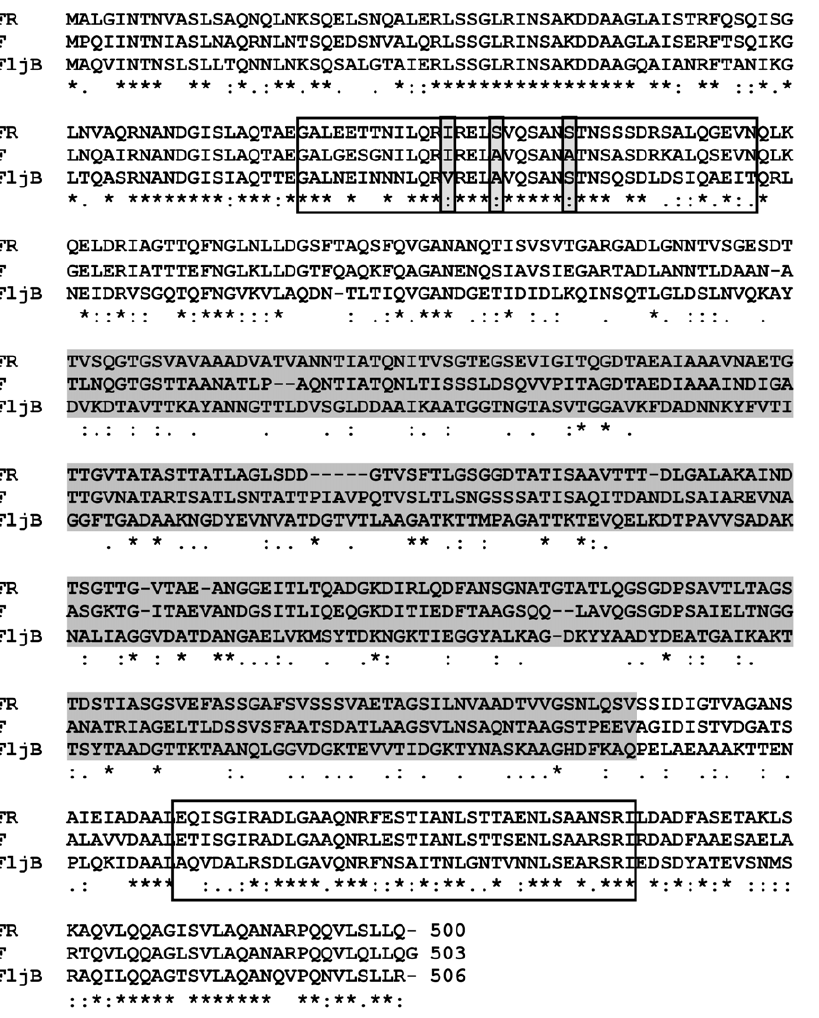
Figure 1. Comparison of the flagellin amino acid sequences of MA (FR and F) and STF (FljB). Boxed areas indicate putative TLR5 binding domains. Grey sequences show hypervariable domains. *,denotes identical amino acids. :, denotes related amino acids.